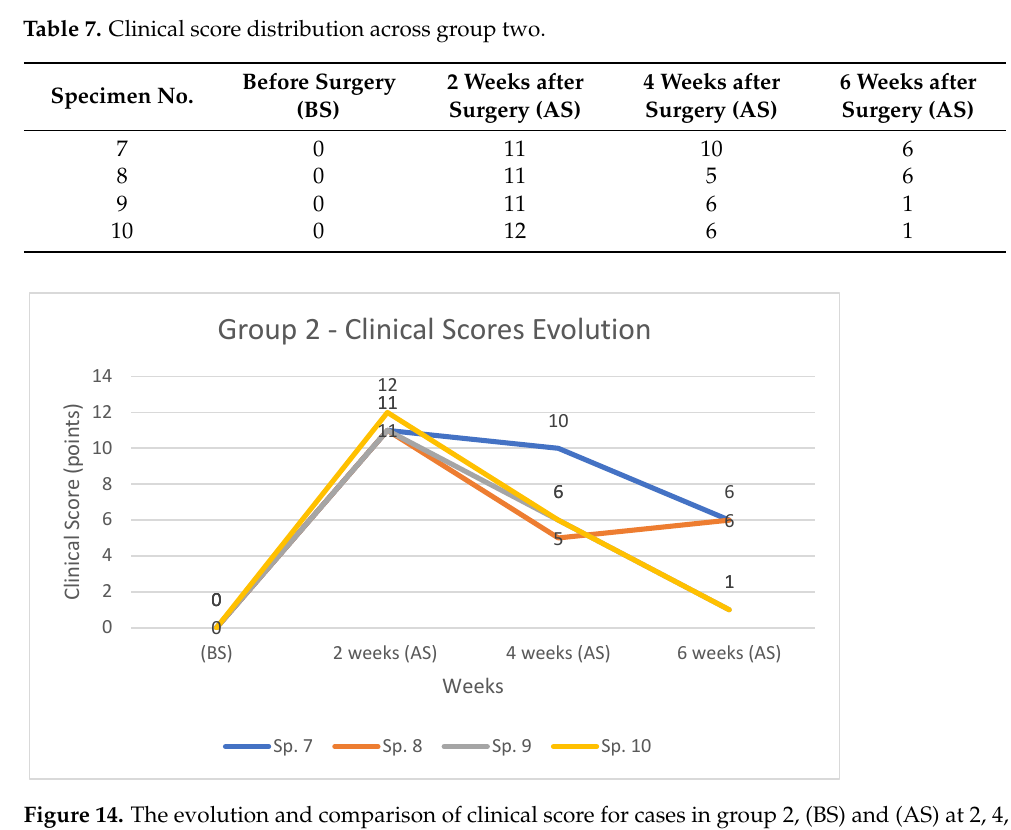
Table 7. Clinical score distribution across group two.